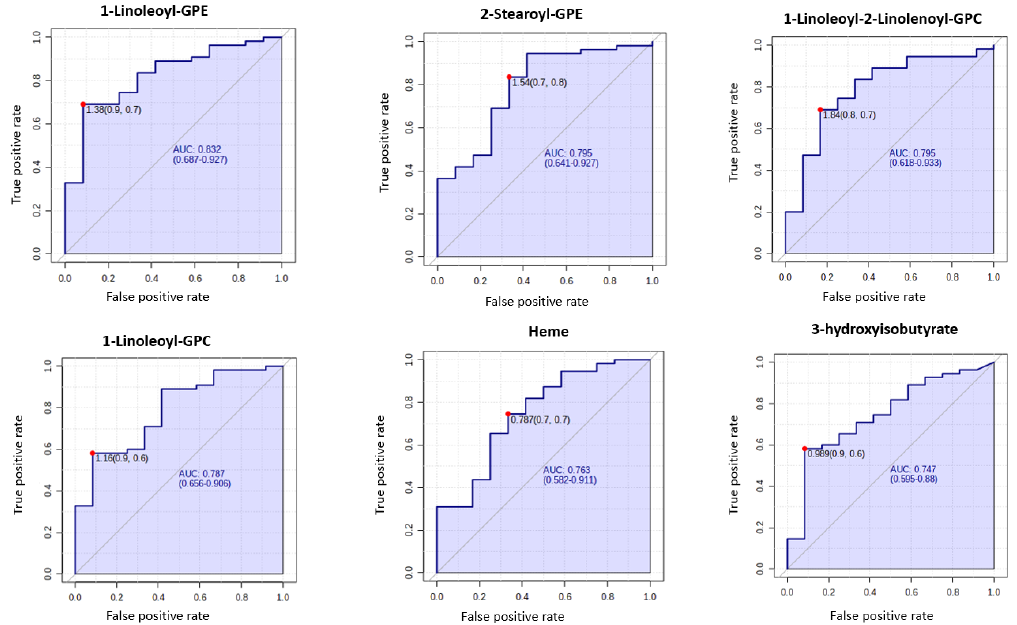
Figure 9. ROC curves of the promising biomarkers for the prediction of lymphovascular space invasion ( n = 12) based on AUC analyses of n = 67 cancers. The optimal cut-off was based on the closest to the top left corner principle and is indicated by the red dot in the ROC curves. Metabolites starting with X are unnamed; the pathways of these are unknown.